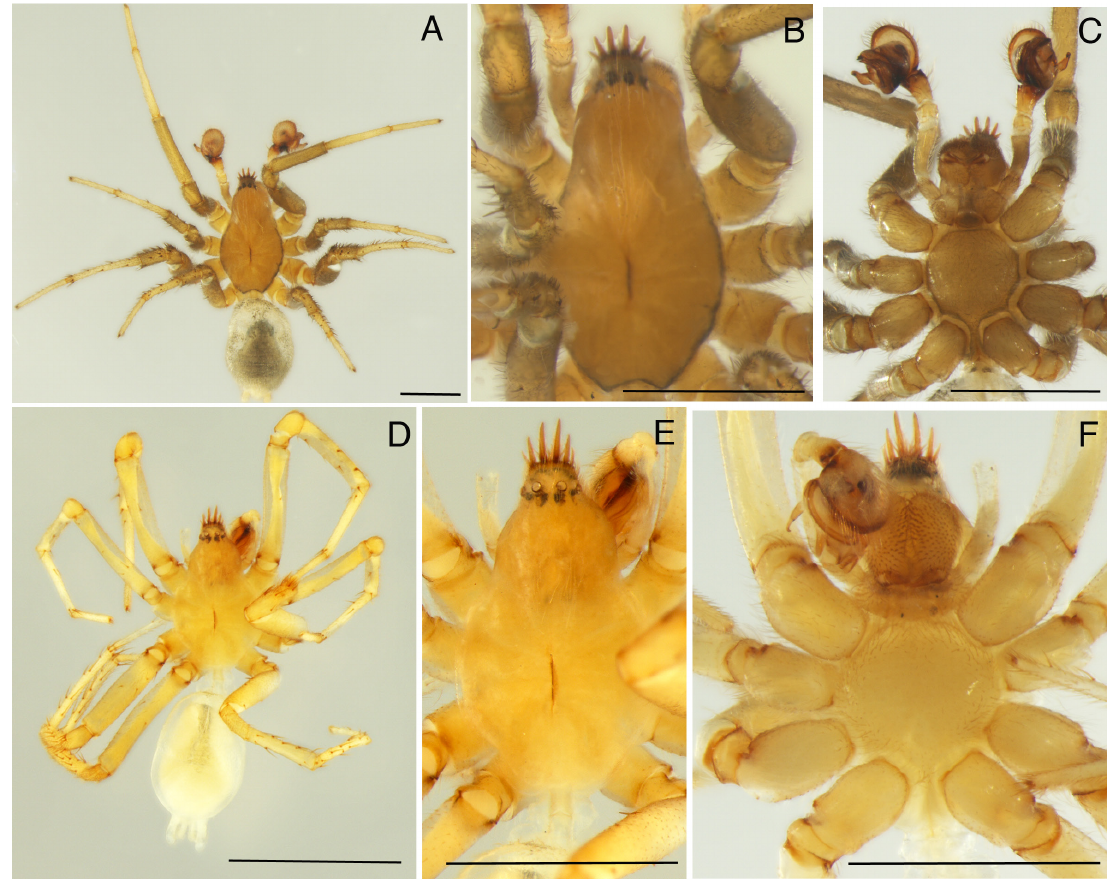
Fig. 1. – A-C . Cyrioctea sawadee sp. nov., ♂ . A . habitus , dorsal view. B . Carapace, dorsal view. C . Idem, ventral view. – D-F . Cyrioctea lotzi sp. nov., ♂ . D . habitus, dorsal view. E . Carapace, dorsal view. F . Idem, ventral view. (Scale bars: 2